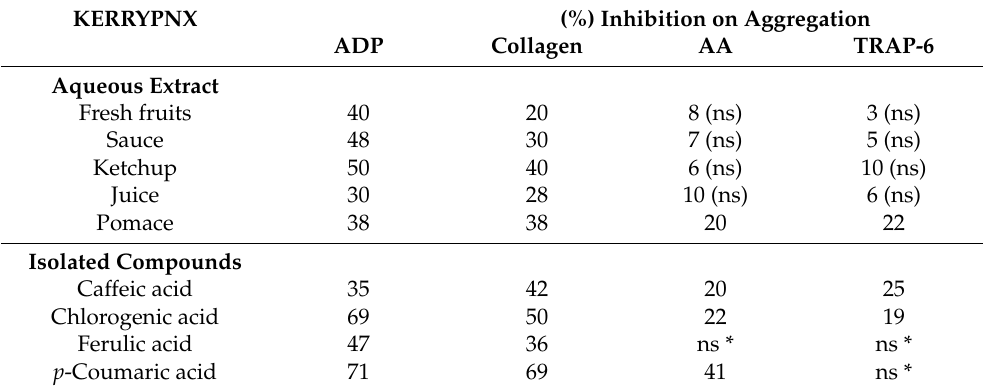
Table 3. Antiplatelet effects of aqueous extracts of S. lycopersicum and its isolated phenolic com- pounds [108].